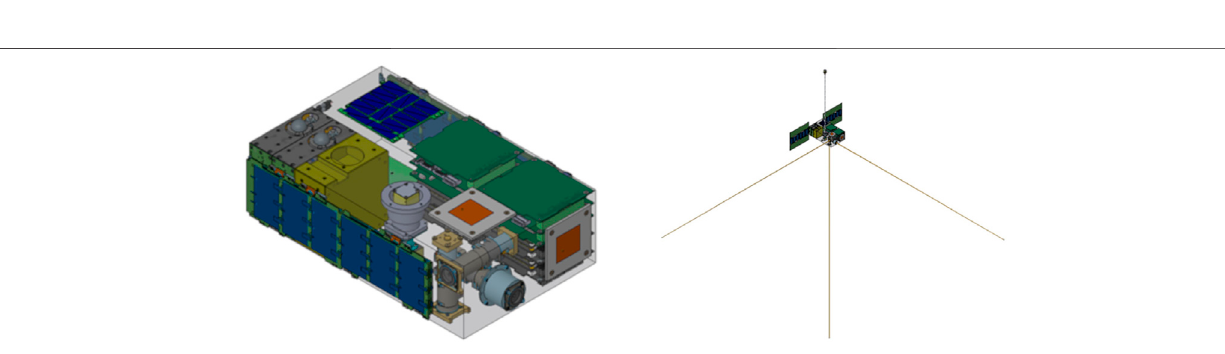
Frontiers in Astronomy and Space Sciences |